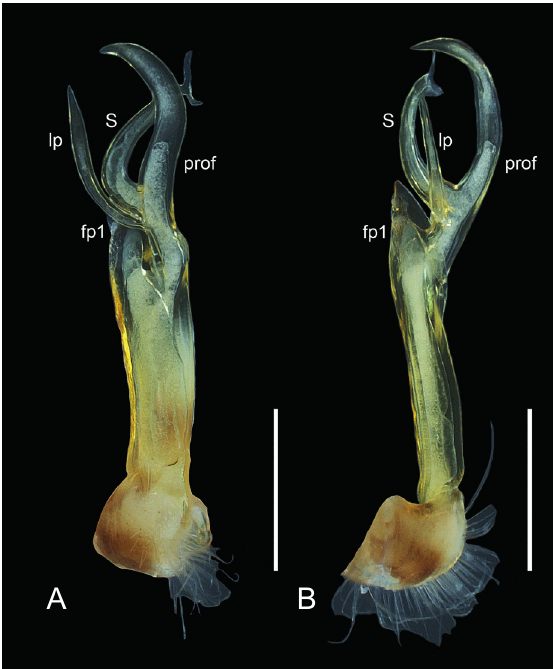
Fig. 10. Pogonosternum nigrovirgatum (Carl, 1902), male, right gonopod (QM 23:40346). A . Posterior view. B . Lateral view. Scale bars: 0.5 mm.